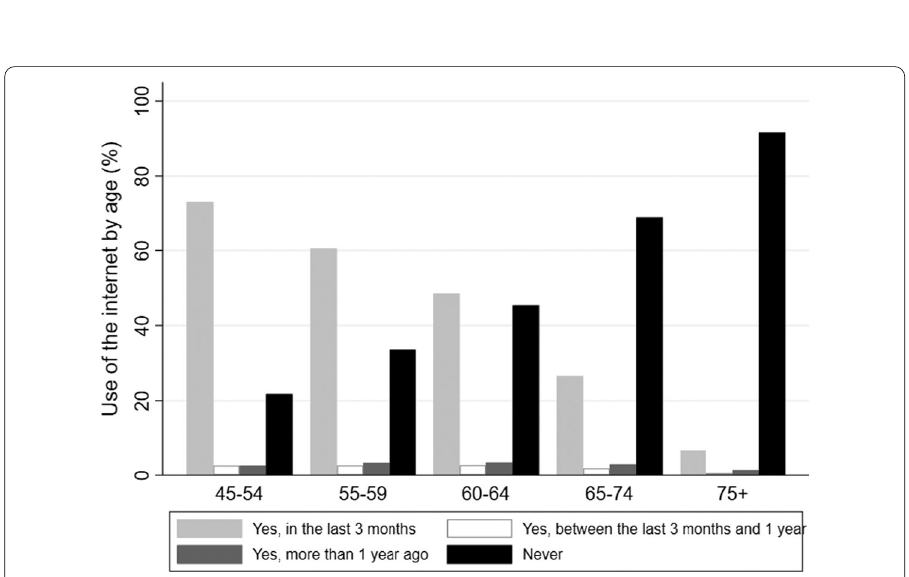
Fig. 2 Use of the Internet by age (Source: Aspects of Daily Life (AVQ),